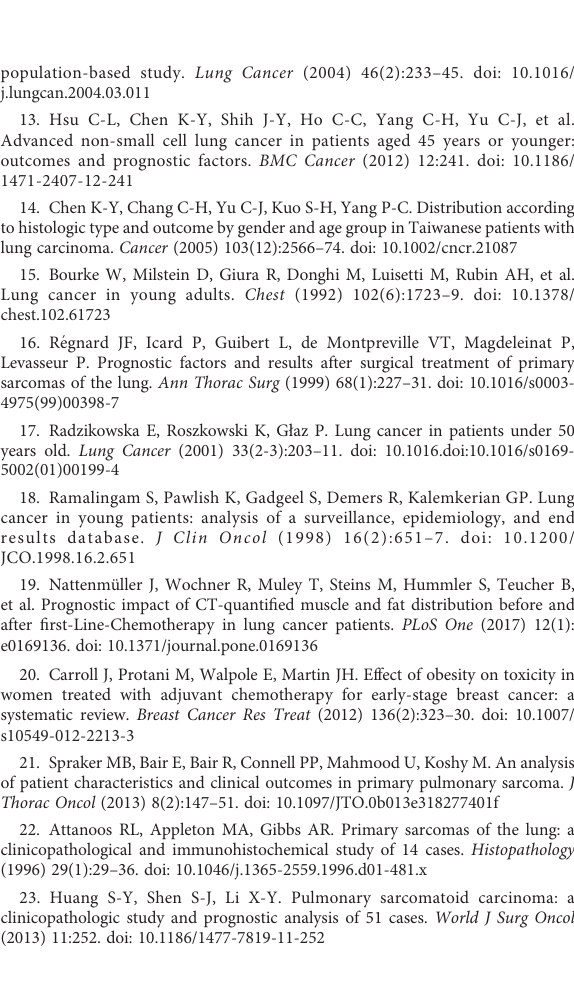
SUPPLEMENTARY TABLE 1 Univariate survival analysis using a non-parametric test on each